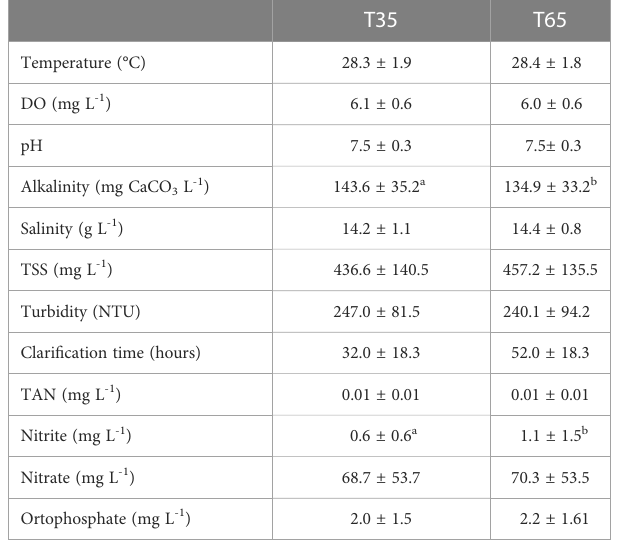
TABLE 1 Water quality parameters in treatments T35 (540 shrimp m -3 + 35 fi sh m -3 ) and T65 (540 shrimp m -3 + 65 fi sh m -3 ) throughout the experimental period (mean values ± standard deviation).